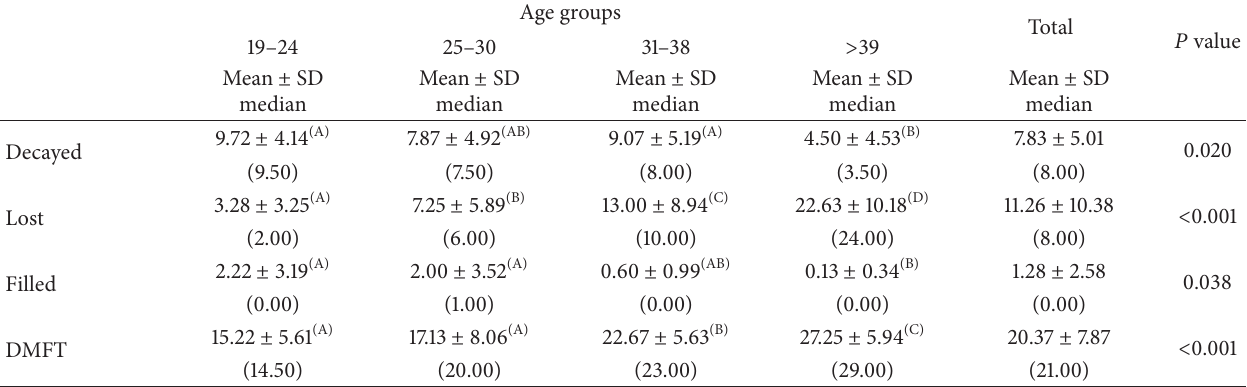
Table 3: Tooth loss assessment according to age group, DMFT index, and decayed and filled